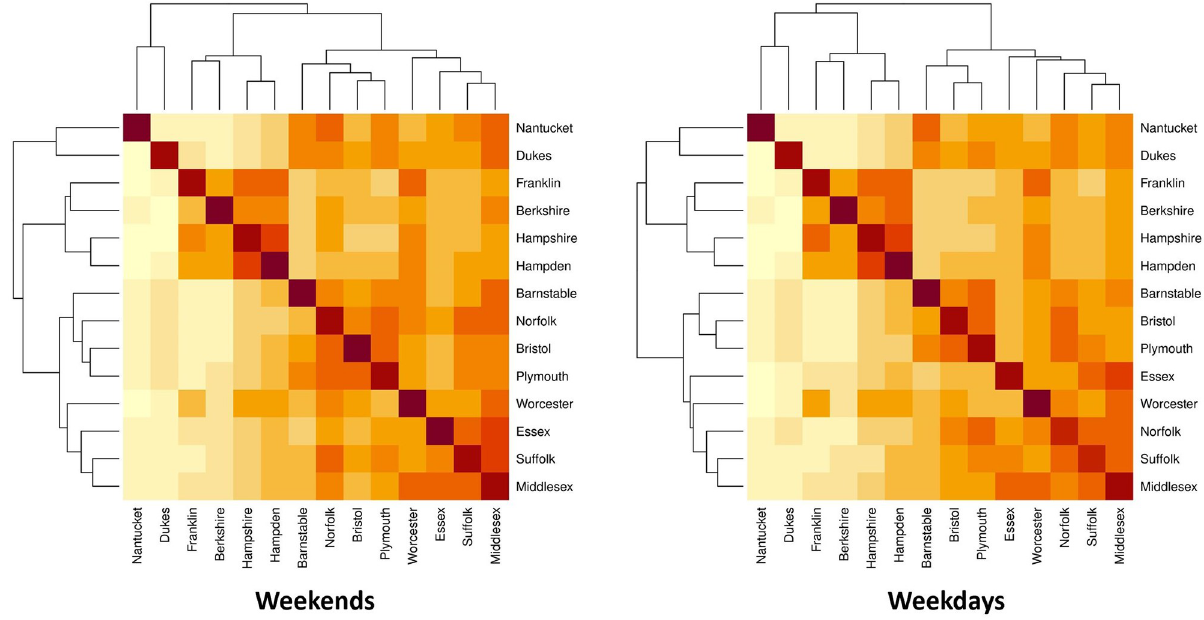
Fig 4. Heat maps for average population flow (log scaled) across regions during weekdays and weekends. Darker colors indicate regions with more flow between them.